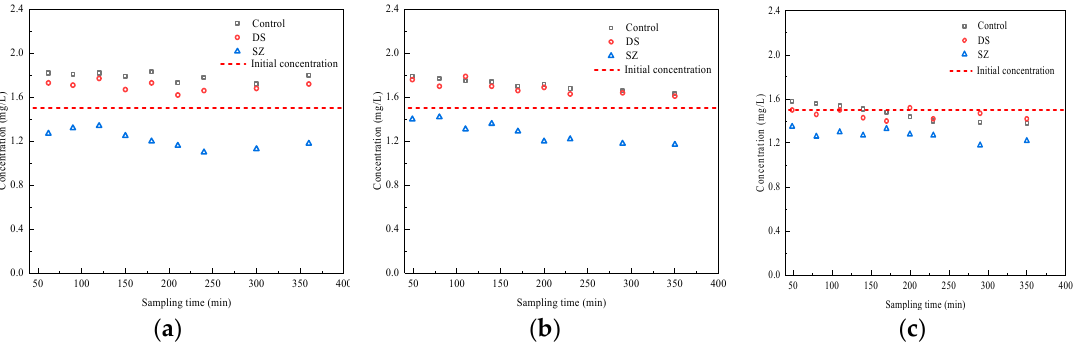
Figure 5. Concentration of NO 3 − -N using bioretention systems with the Control column, DS column, and SZ column under 1a ( a ), 5a ( b ), and 10a ( c ) rainfall intensities.